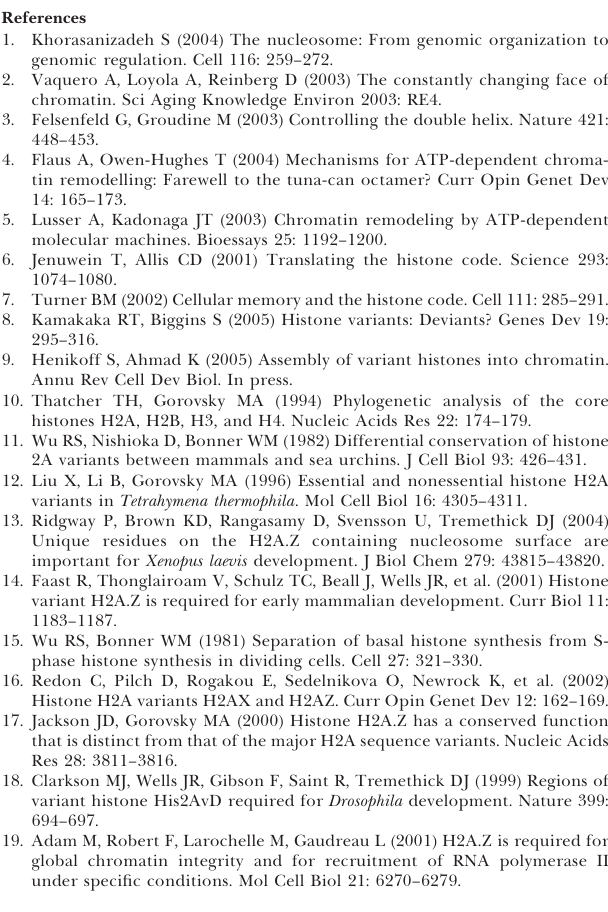
Table S2. Smoothed Data for the H2A.Z/H2B ChIP–Chip Experiment For every coordinate within the genome, the H2A.Z/H2B ratio derived from the raw data by the Gaussian plot analysis is shown. This file is a text file ready for display within the UCSC Genome Browser. Found at DOI: 10.1371/journal.pbio.0030384.st002 (10.8 MB ZIP). Table S3. Smoothed Data for the H2A/H2B ChIP–Chip Experiment For every coordinate within the genome, the H2A/H2B ratio derived from the raw data by the Gaussian plot analysis is shown. This file is a text file ready for display within the UCSC Genome Browser. Table S4. Smoothed Data for the H2A.Z/H2A.Z ChIP–Chip Experi- ment For every coordinate within the genome, the H2A.Z/H2A.Z ratio derived from the raw data by the Gaussian plot analysis is shown. This file is a text file ready for display within the UCSC Genome Browser. Table S5. List of Z Loci A table listing the position of each Z loci identified in this study. Table S6. Genome Browser-Ready File